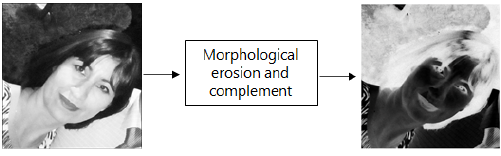
Figure 18. Operations to build grayscale